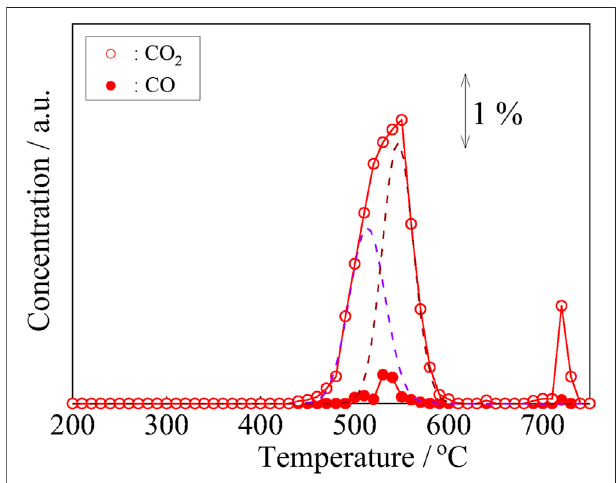
FIGURE 9 | Temperature-programmed oxidation under a humidi fi ed He fl ow (H 2 O-TPO) for the Ni/SDC powder after the CH 4 treatment at 700 ° C for 1 h. TPO condition He gas after passing through a H 2 O bubbler at a fl ow rate of 50 ml · min − 1 . The reaction temperature increased from 200 to 700 ° C with the rate of 1 ° C min − 1